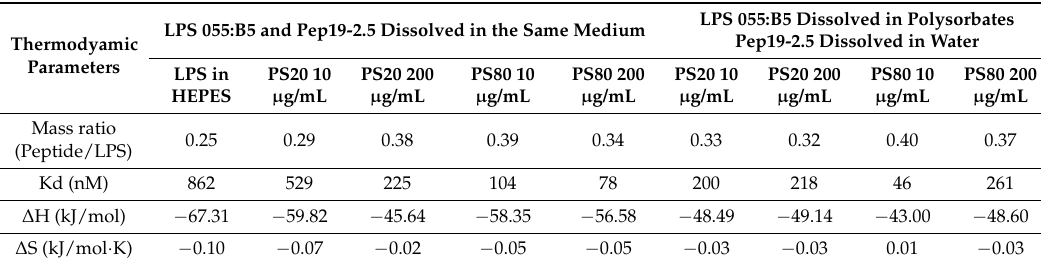
Table 1. Thermodynamic parameters of the interaction of LPS from E. coli 055:B5 with the synthetic anti-endotoxin peptide (Pep19-2.5) formulations. PS: polysorbate.